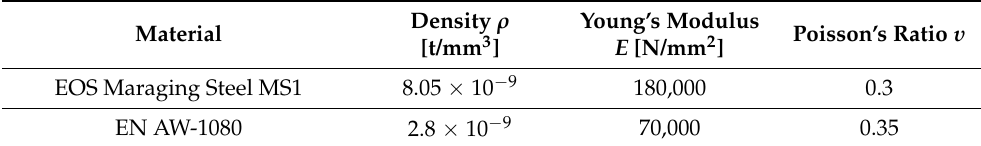
Table 1. Material properties of the tool and piece [25,30,31].